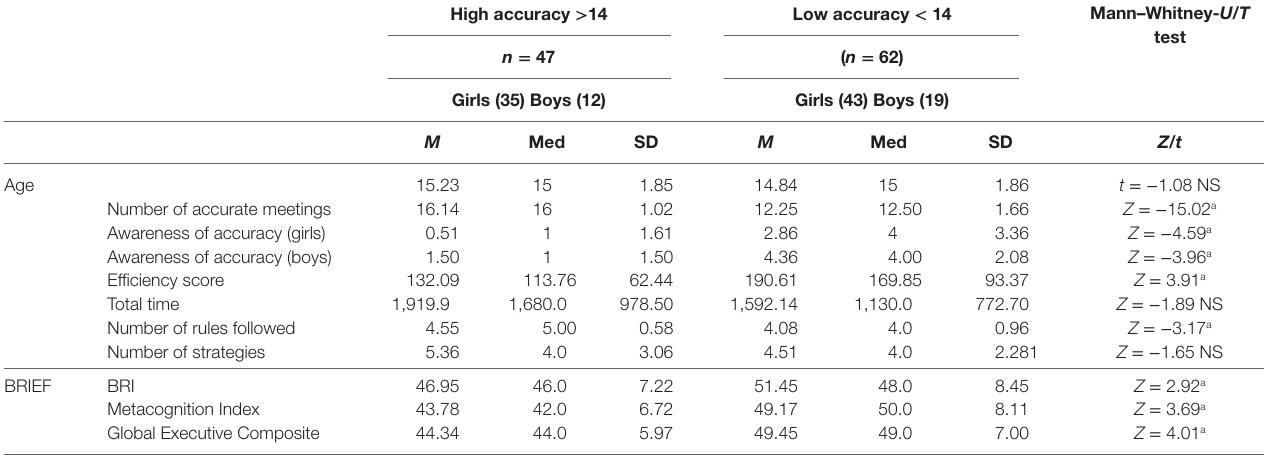
TaBle 2 | Comparison between high and low weekly calendar planning activity (WCPA) accuracy groups on parental reports of executive functions (EF) (BRIEF) and other WCPA measures.